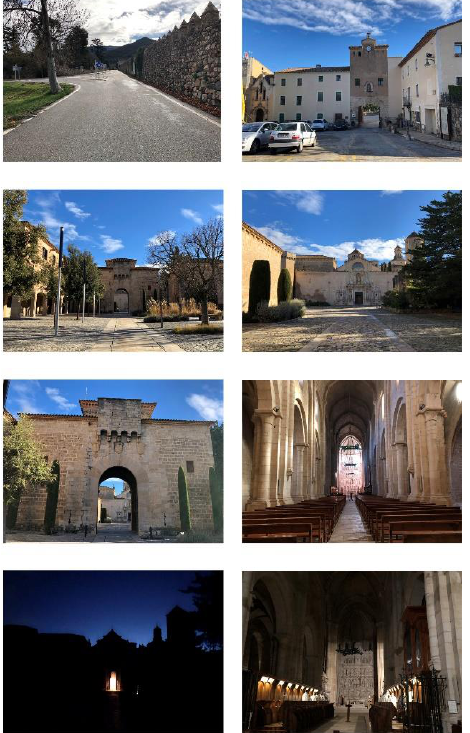
Figure 21. Worship itinerary of Poblet Monastery.